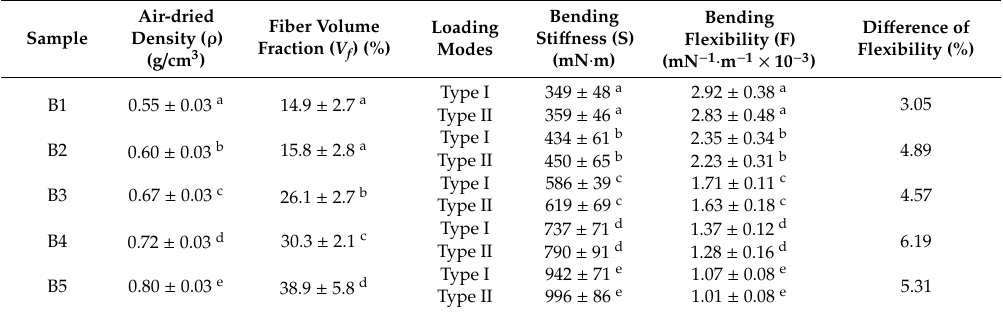
Table 1. The physical and mechanical properties of bamboo slivers under di ff erent bending Types. Sample